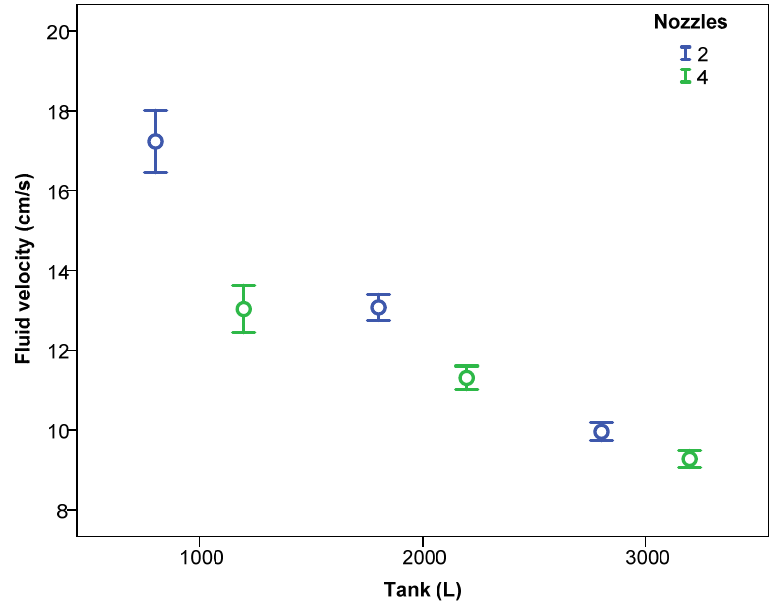
Figure 5. Fluid velocity (mean ± 95% confidence interval) according to the level of water in the tank and pressures of the nozzle circuits.